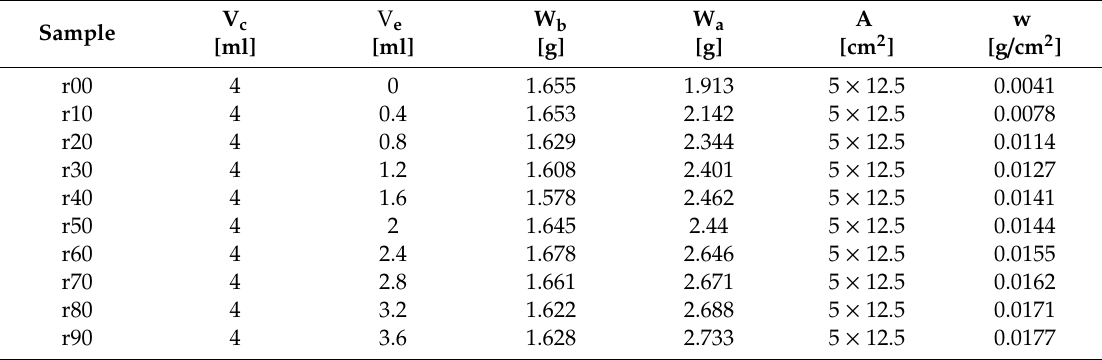
Table 2. Solid add-on of coated samples.